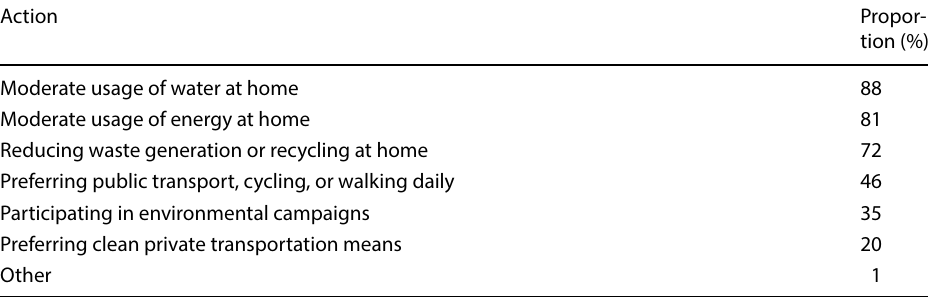
Table 12 Proportion of people taking action to mitigate climate change in the last 12